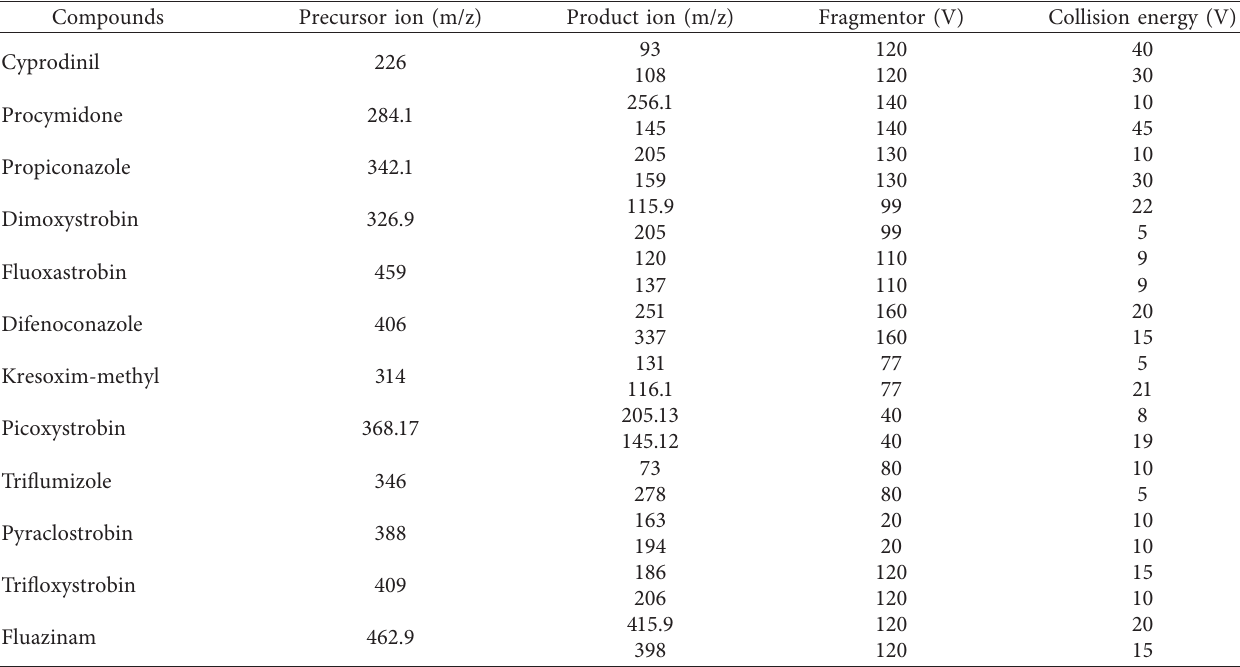
Table 2: Retention time, regression equation, correlation coefficient, linear range, and determination limit of 31 pesticides.